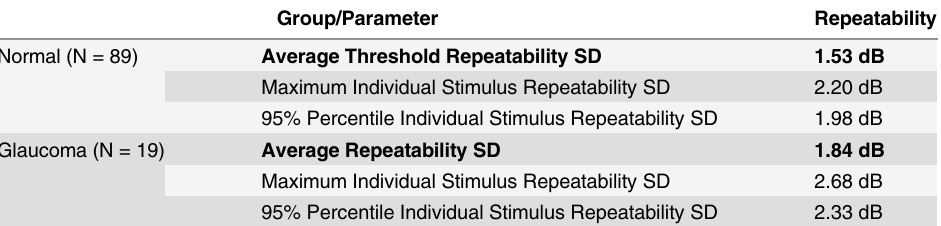
Table 3. Compass repeatability: SD for Average sensitivity and individual stimuli